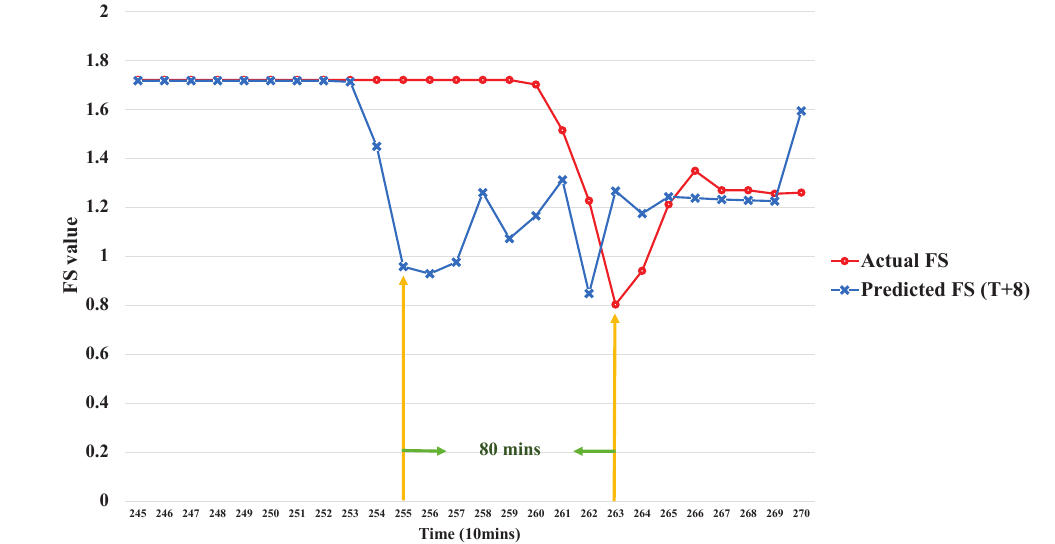
Figure 14. Landslide early warning time